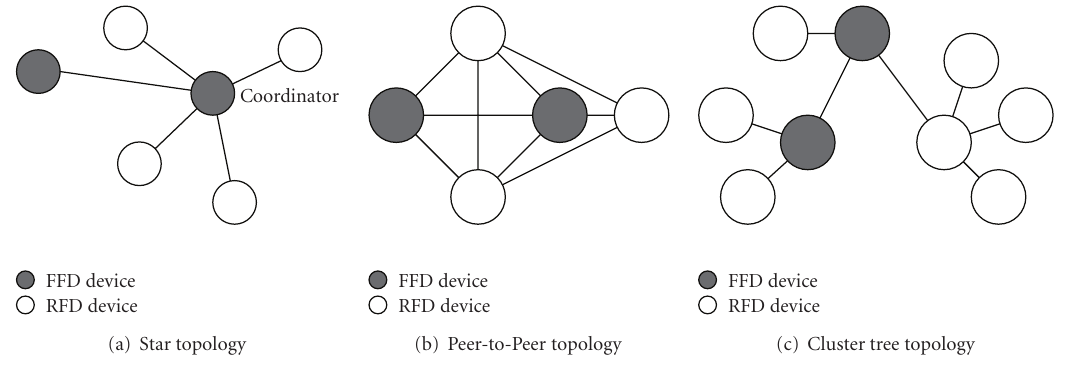
Figure 1: Various topologies in IEEE 802.15.4 networks.